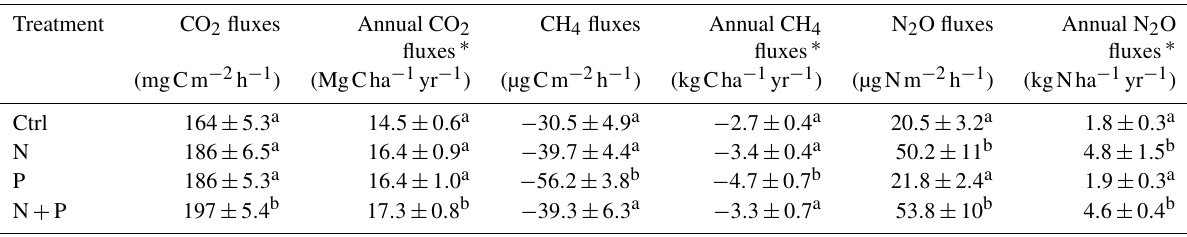
Table 2. Mean ( ± SE; n = 4) soil GHG fluxes (CO 2 , CH 4 , and N 2 O) and annual soil GHG fluxes measured between May 2019 and June 2020 from control (Ctrl), nitrogen (N), phosphorus (P), and N + P plots of the nutrient manipulation experiment.